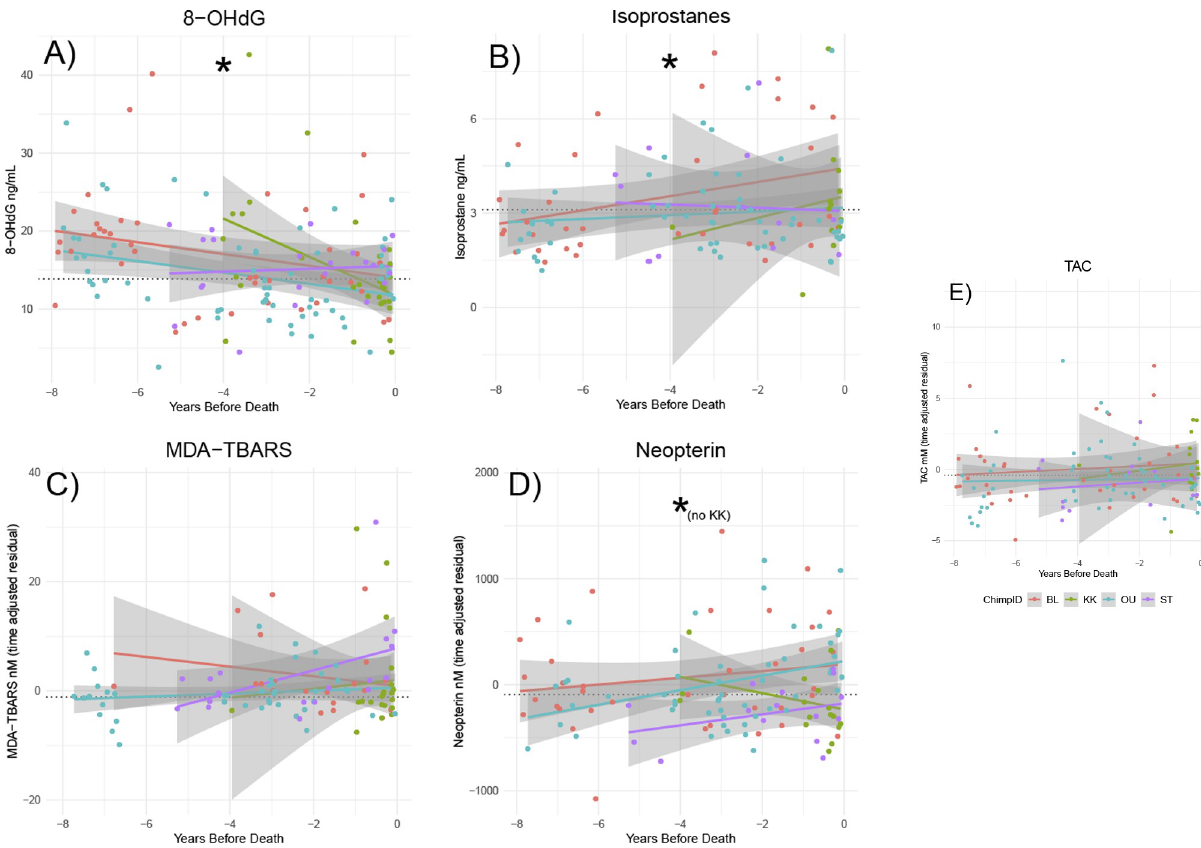
Fig 5. Variation in OS biomarkers by year before individuals’ death. � A) 8-OHdG decreased and B) Isoprostanes increased among the 4 subjects as they approach death. D) Neopterin increased among past-prime individuals as they approached death. Solid line drawn with simple linear regression, unlike mixed effect models that determined significance. Black dotted line represents population median in biomarker from samples unrelated to epidemic, injury or eventual death.